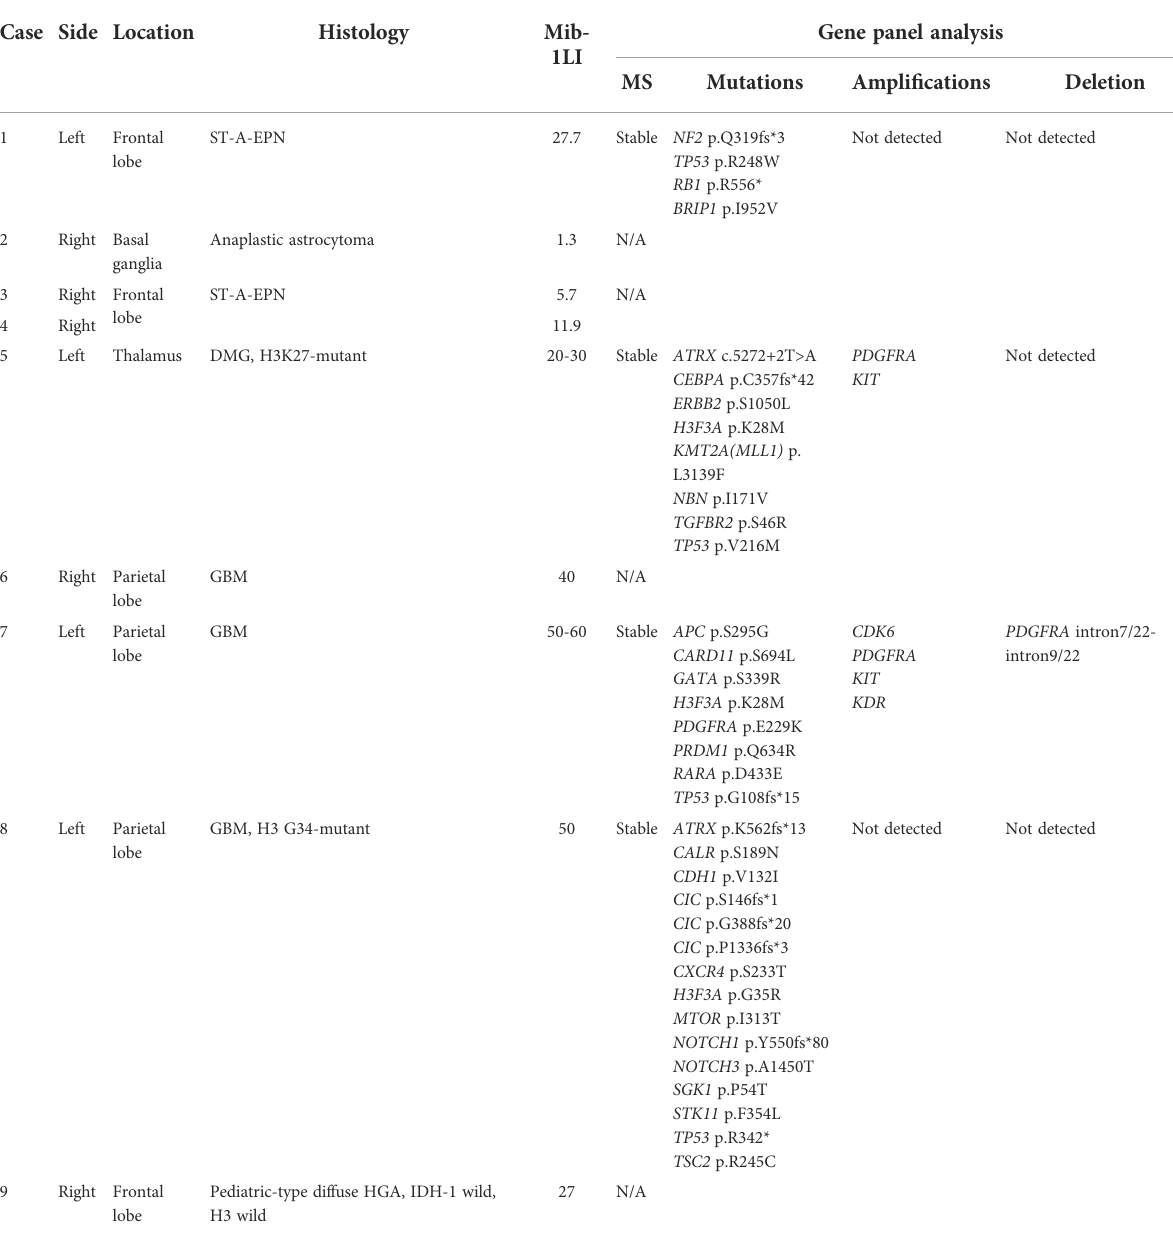
TABLE 4 Histology and molecular